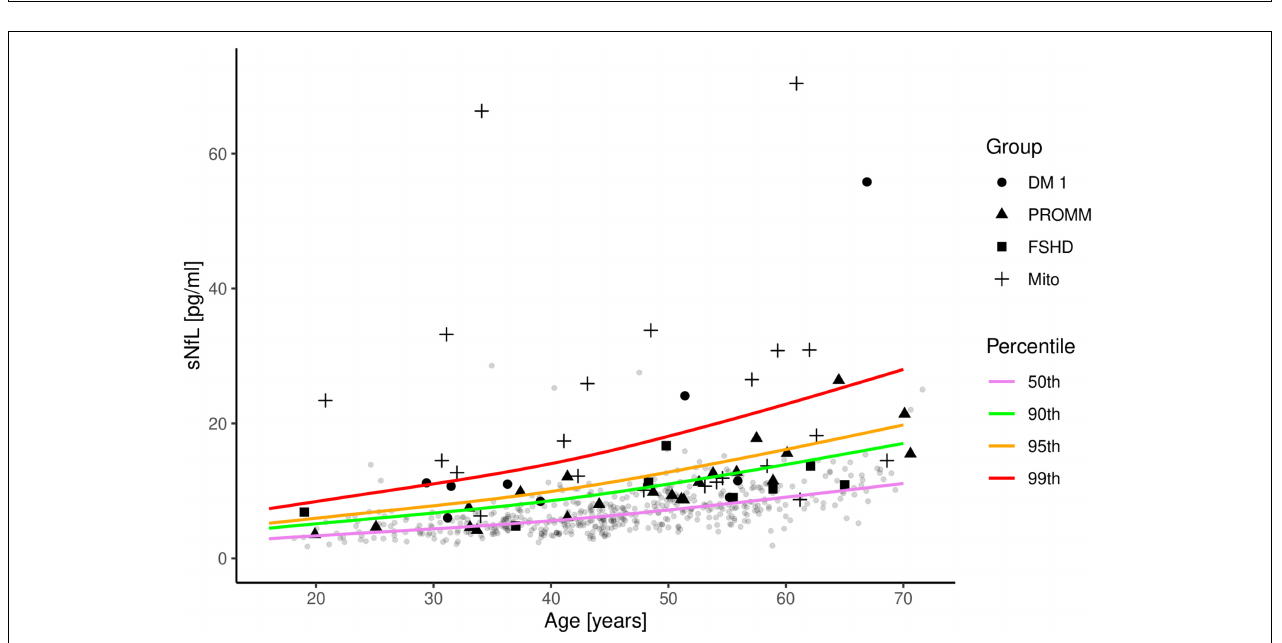
FIGURE 1 | Boxplot diagram of serum neurofilament light chain (sNfL) concentrations, comparing the disease groups against healthy control samples. Boxes represent median and interquartile range (IQR) and whiskers the extreme value within 1.5 × IQR above and below the median. The p -values listed were determined using a Wilcoxon rank-sum test.